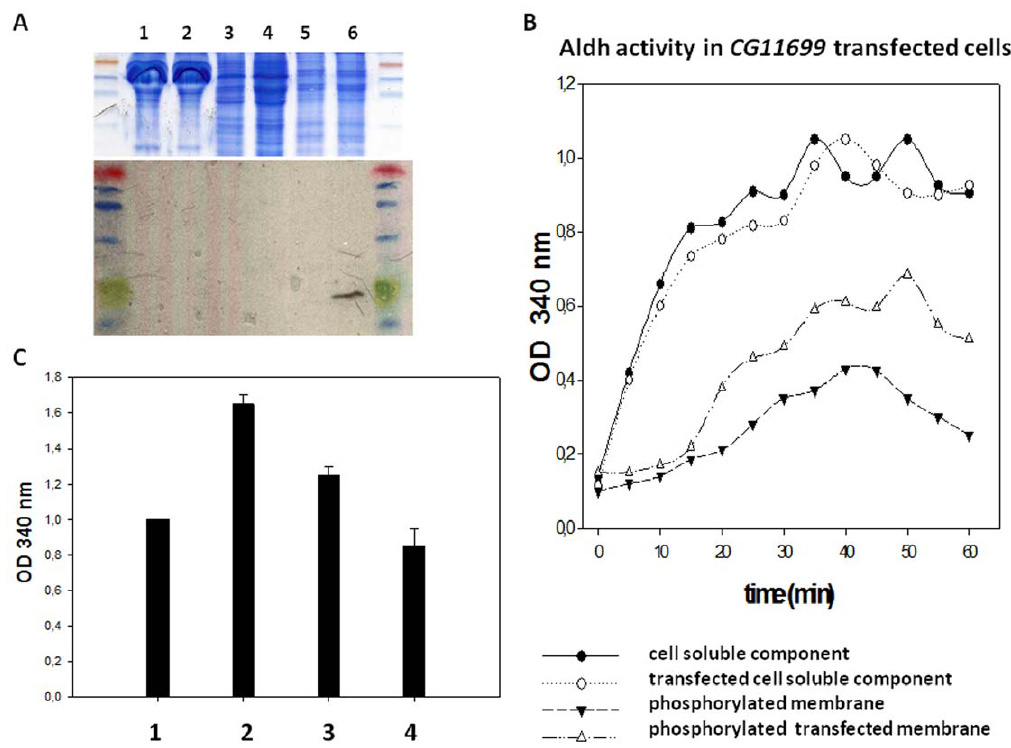
Figure 8. Aldh activity analysis of S2 cells stably transfected with a CG11699 transgene. S2 cells were stably transfected with an expression vector bearing the CG11699 coding sequence. A stable cell line expressing CG11699 was generated by transfection with a plasmid containing CG11699-pMT/V5-His and pCoHygro (the E. coli hygromycin-B phosphotransferase gene under the control of a Drosophila Copia promoter). Stable cells were treated with 0.5 mM CuSO 4 for 24 hr to induce CG11699 expression before use. (A) Electrophoresis protein gel analysis: lane 1, total extracts of control cells; lane 2, total extracts of transfected cells; lane 3, soluble extracts of transfected cells; lane 4, soluble extracts of transfected cells after induction; lane 5, membrane extracts of transfected cells; lane 6, membrane extracts of transfected cells after induction. A Western blot analysis shows the presence of the expressed transgene using anti-V5 tag in the membrane fraction. (B) The induction of stably transfected cells was carried out one day prior to Aldh activity analysis. The cells were then disrupted by osmotic shock followed by brief sonication. The resulting extracts were briefly centrifuged to remove nuclei and organelles. The supernatant was again centrifuged to pellet the membrane fraction (13000 rpm for 30 minutes at 4 u C) and the Aldh dosage was carried out for both components (soluble and membrane). The same amount of protein was used for the soluble fraction (100 m g) and for the membrane fraction (200 m g). Membranes were incubated or not with PKA subunit (10 units), ATP (50 m M) and Mg ++ (1 mM) prior to Aldh activity determination. The curves represent the average of three determinations. (C) Comparative levels of Aldh-III activity in the membrane component from stably induced transfected cells, incubated or not with Br-cGMP and/or Br-cAMP three hours before the experiment. 1, control induced transfected cells; 2, induced transfected cells treated with Br-cGMP; 3, induced transfected cells treated with Br-cAMP; 4, control non transfected cells (with the inducer) treated with Br-cGMP. The bars represents the mean + / 2 S.E. of three individual determinations. p , 0.001 Student’s t -test between tracks 1 and 2. We observed elevated levels of Aldh activity after Br-cGMP treatment (0,8 + / 2 0,15 for the non transfected cell control treated with the inducer versus 1,7 + / 2 0,15 for the induced transfected cells after br-cGMP treatment in both cases).